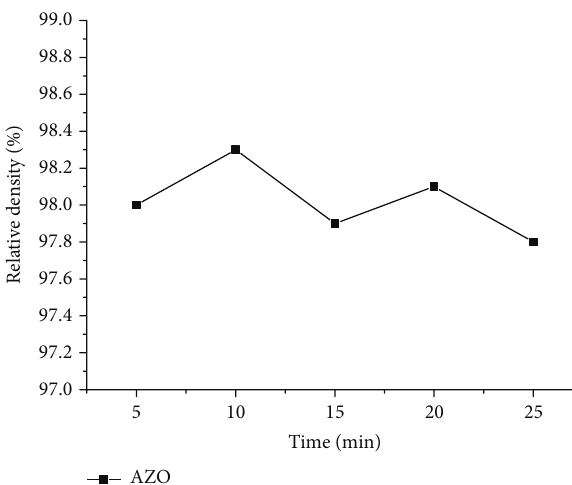
Figure 9: Relative densities of AZO targets as a function of microwave starting temperature.